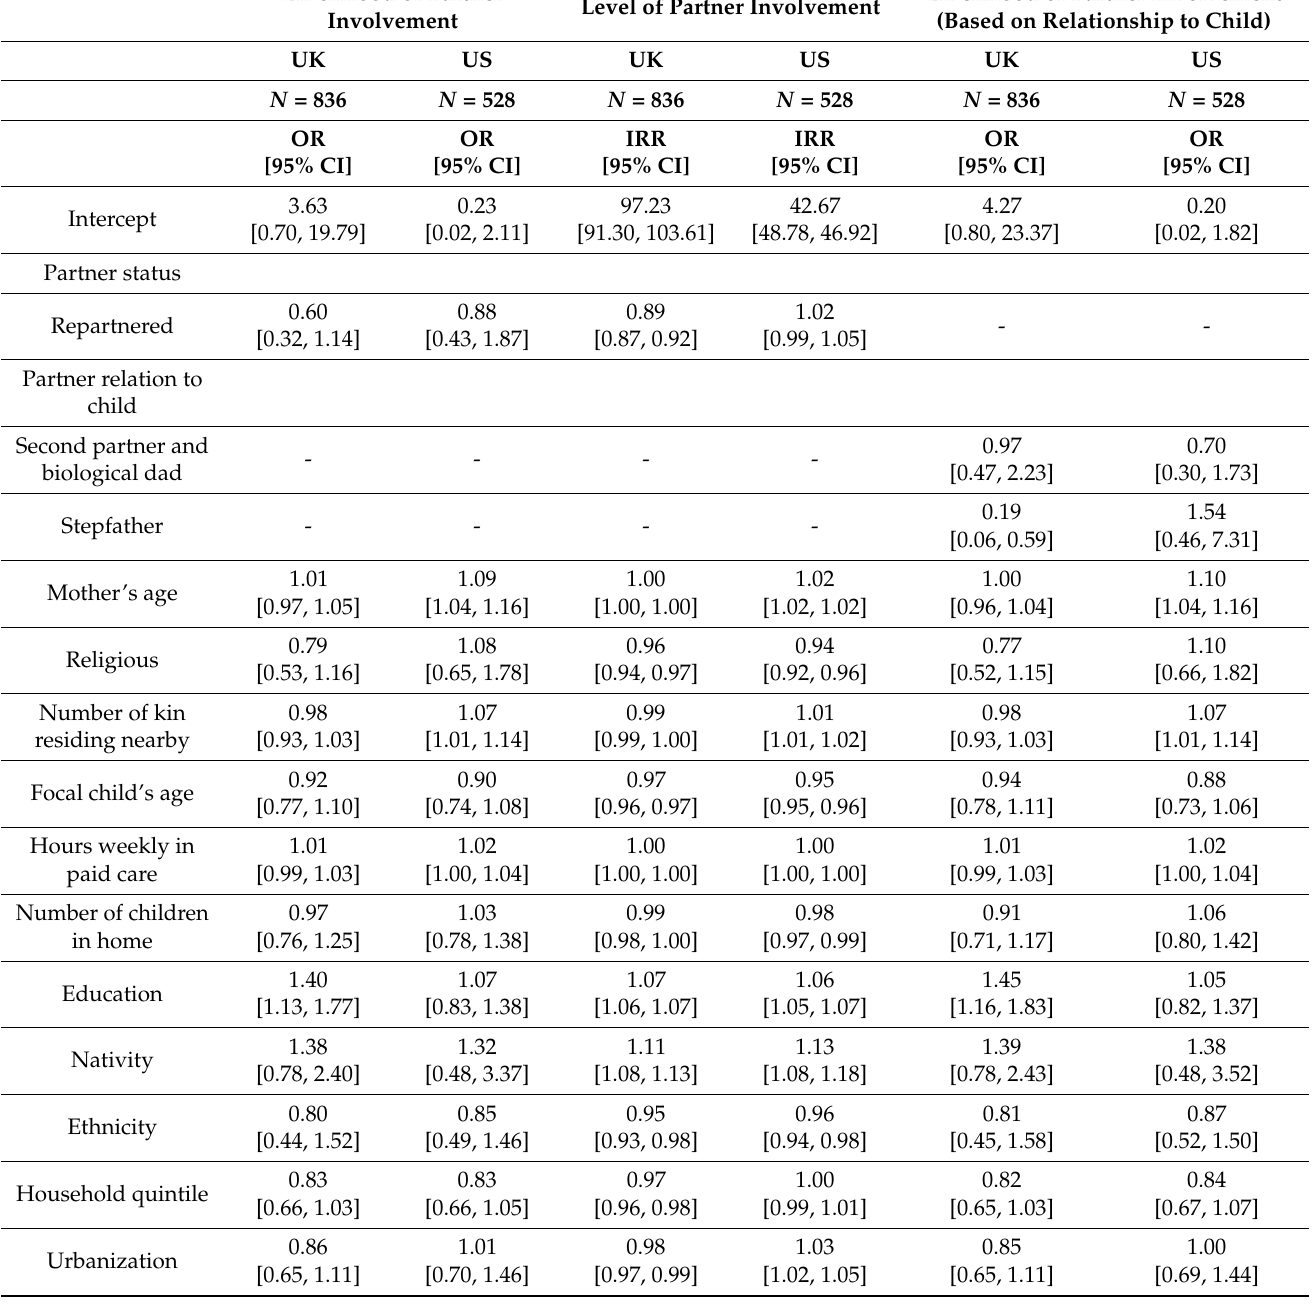
Table 2. Results of Bayesian regression models predicting partner involvement in the US and in the UK. Likelihood of Partner Involvement Likelihood of Partner Level of Partner Involvement (Based on Relationship to Involvement